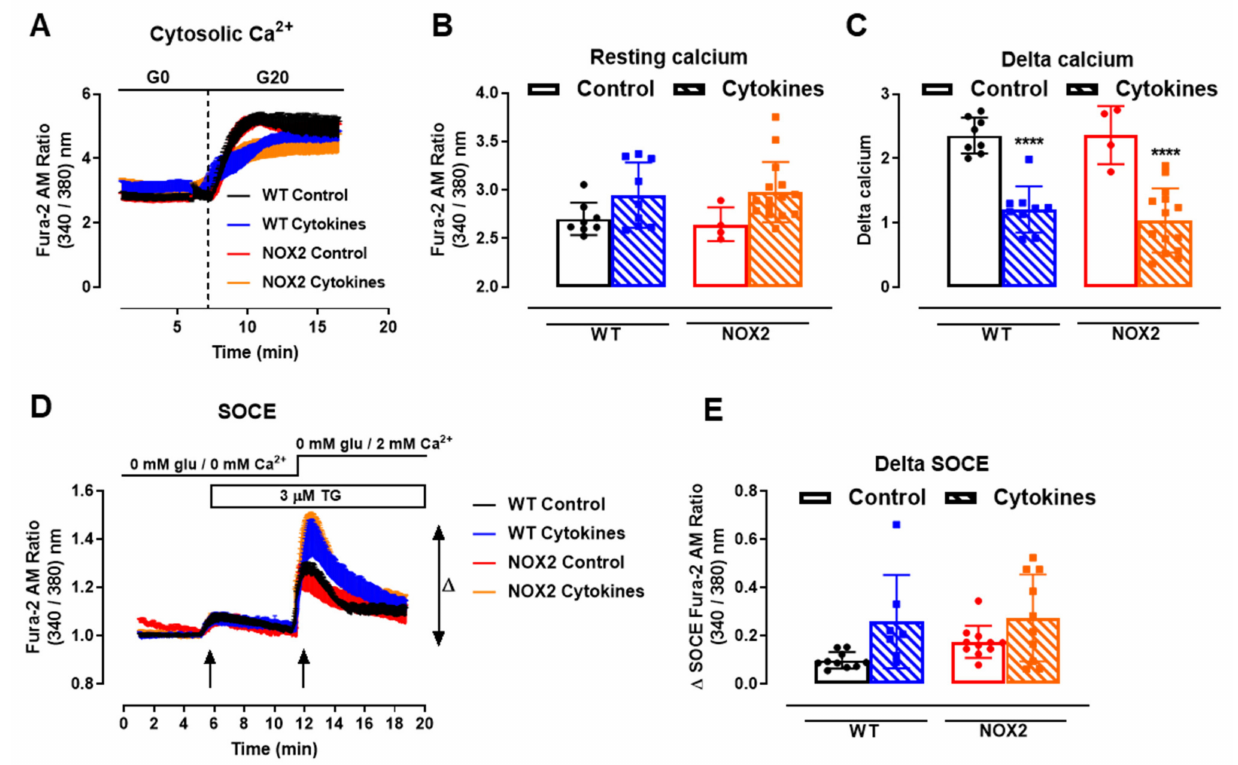
Figure 5. Ca 2+ homeostasis of the islets from C57BL/6J (WT) and NOX2 KO (NOX2) mice exposed to proinflammatory cytokines. ( A ) Dynamic measurements of the total Ca 2+ of islets from WT and NOX2 mice incubated for 24 h in 10-mM glu- cose in the absence (Control) or presence of a proinflammatory cytokine mix (10-U/mL IL-1 β + 100-U/mL TNF + 14-U/mL IFN- γ ). After incubation, the Ca 2+ measurements were performed using Fura-2 AM dye under the microscope Axio Observer 7 for 5 min without glucose (G0) and up to 20 min with 20-mM glucose (G20). The dashed vertical line represents the addition of glucose. ( B ) Resting calcium, before the addition of glucose. ( C ) Delta, representing the response to glucose. The delta was calculated by ∆ = mean 11 min − mean 7.5 min in each group. The results are expressed as the mean ± SD of 4–15 individual islets (from 3 to 4 different animals per genotype). ( D ) Dynamic measurements of the Store-Operated Ca 2+ Entry (SOCE) mechanism of islets from WT and NOX2 mice incubated for 24 h in 10-mM glucose in the absence (Control) or presence of a proinflammatory cytokine mix (10-U/mL IL-1 β + 100-U/mL TNF + 14-U/mL IFN- γ ). After incubation, Ca 2+ measurements were performed using Fura-2 AM dye under the microscope Axio Observer 7 in three steps: (1) in glucose-free and calcium-free medium (0-mM glu/0-mM Ca 2+ ); followed by (2) the addition of 3- µ M thapsigargin (TG, first arrow), then followed by (3) the addition of 3- µ M thapsigargin and 2-mM calcium-supplemented medium (0-mM glu/2-mM Ca 2+ , second arrow). ( E ) ∆ SOCE as indicated in ( D ). The results are expressed as the mean ± SD of 7–14 individual islets (from 3 different animals per genotype). **** p < 0.0001 versus the respective control at the same genotypes. One-way ANOVA +